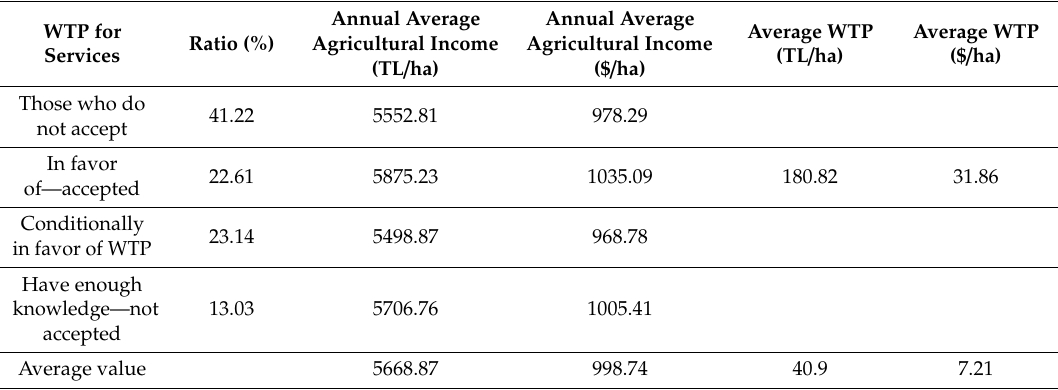
Table 2. Results of the participants’ WTP for services to generate sustainable agricultural